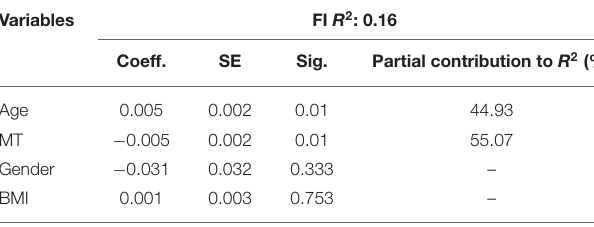
TABLE 4 | Regression analysis for frailty